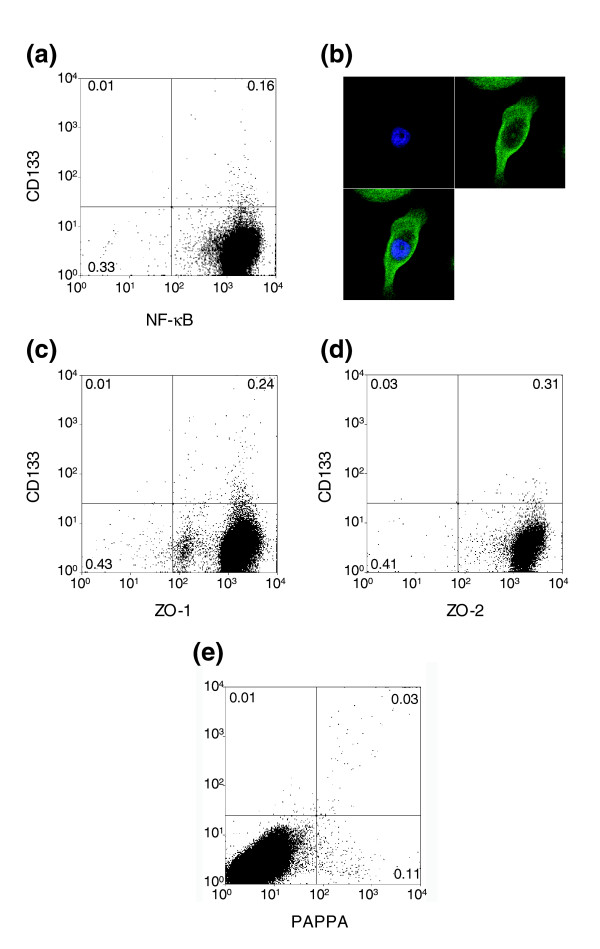
Validation of selected genes by flow cytometry and immunocytochemistry. (a) Flow cytometry analysis of prostate cancer cells co-stained with antibodies to CD133 and the NF-κB p65 subunit. (b) Confocal image of sorted CD133+ cancer cells stained with an antibody to the NF-κB p65 subunit (green) counterstained with DAPI (blue). Nuclear concurrence of two signals is indicated by a cyan colour. (c-e) Flow cytometry analysis of prostate cancer cells co-stained with antibodies to CD133 and ZO1/TJP1 (c) or ZO2/TJP2 (d) or PAPPA (e).